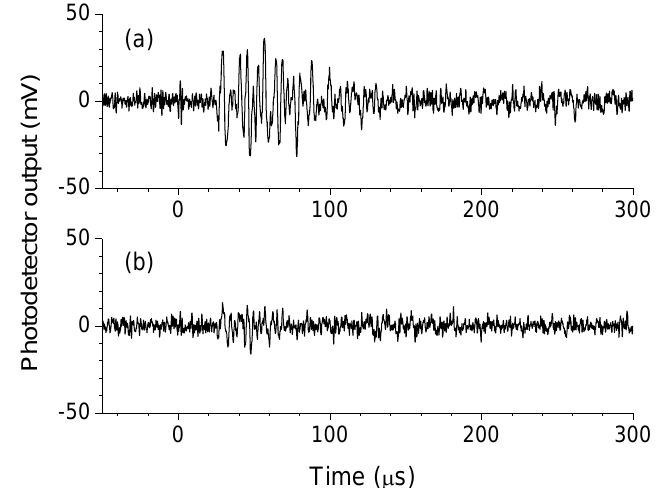
Figure 9. FBG sensor responses to ultrasound ( a ) that was propagated through an intact area and ( b ) propagated through a damaged area.